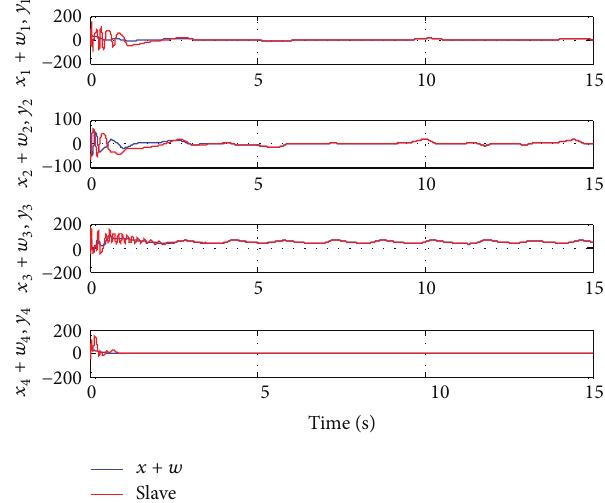
Figure 8: Time histories of the generalized signal (master 𝑥 system plus given function 𝑤 ) and slave system for Case III.